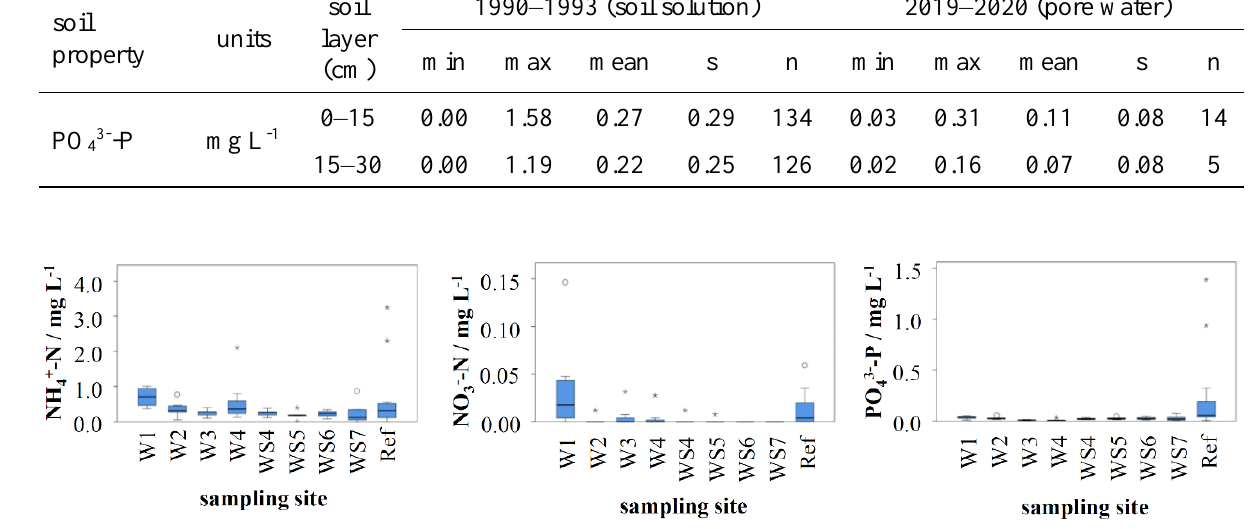
Figure 4. Boxplots of nutrient concentrations in surface water during the follow-up examination in 2019– 2020. W1 = bog pond, W2 = ditch, W3 and W4 = intermittent ponds, WS4–WS7 = intermittent surface water at wetter sites; ° mild outliers, * extreme outliers. Table 4. Summary of surface water properties (see Table A6) from the study preceding the initial examination in 1984–1988 (Eggelsmann & Blankenburg 1989) and the follow-up examination in 2019–2020. N/A = data not available; min = minimum; max = maximum; s = standard deviation; n = sample